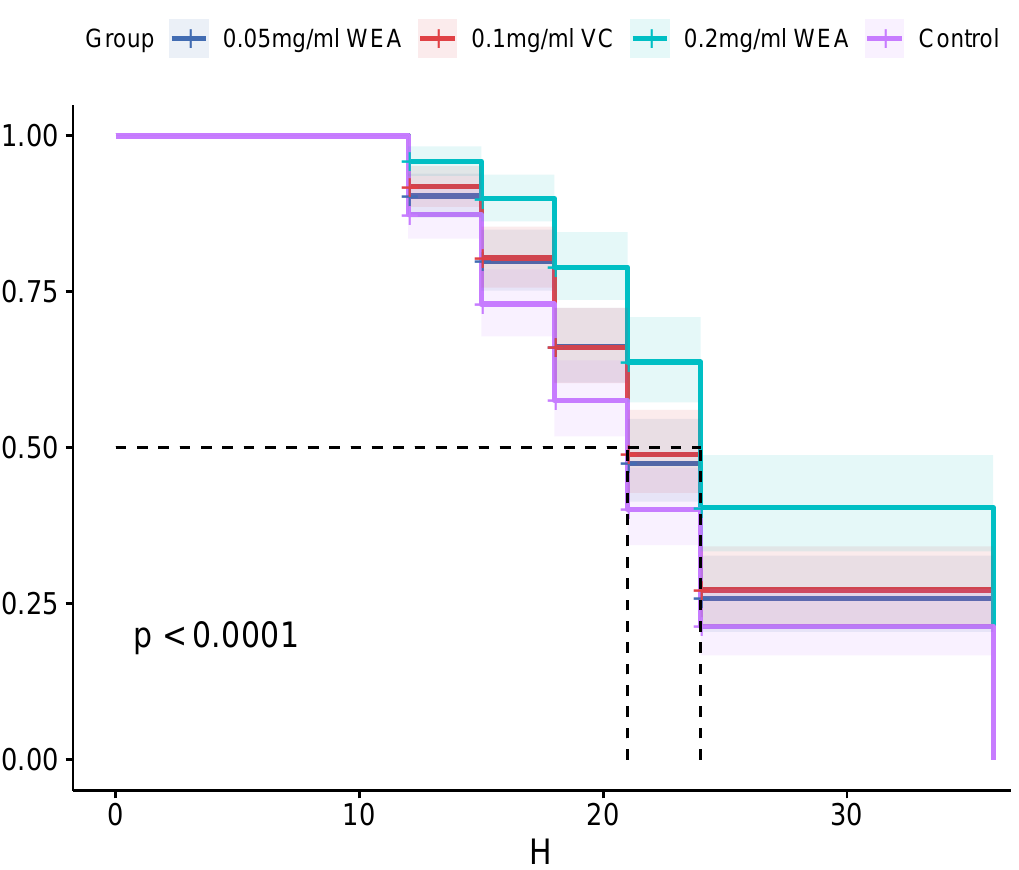
Figure 11. Survival curves of Drosophila reared on different diets: 0.05 mg/mL WEA = 0.05 mg/mL water extract of A. grossedentata + 6 mM paraquat; 0.2 mg/mL WEA = 0.2 mg/mL water extract of A. grossedentata + 6 mM paraquat; 0.1 mg/mL VC = 0.1 mg/mL vitamin C + 6 mM